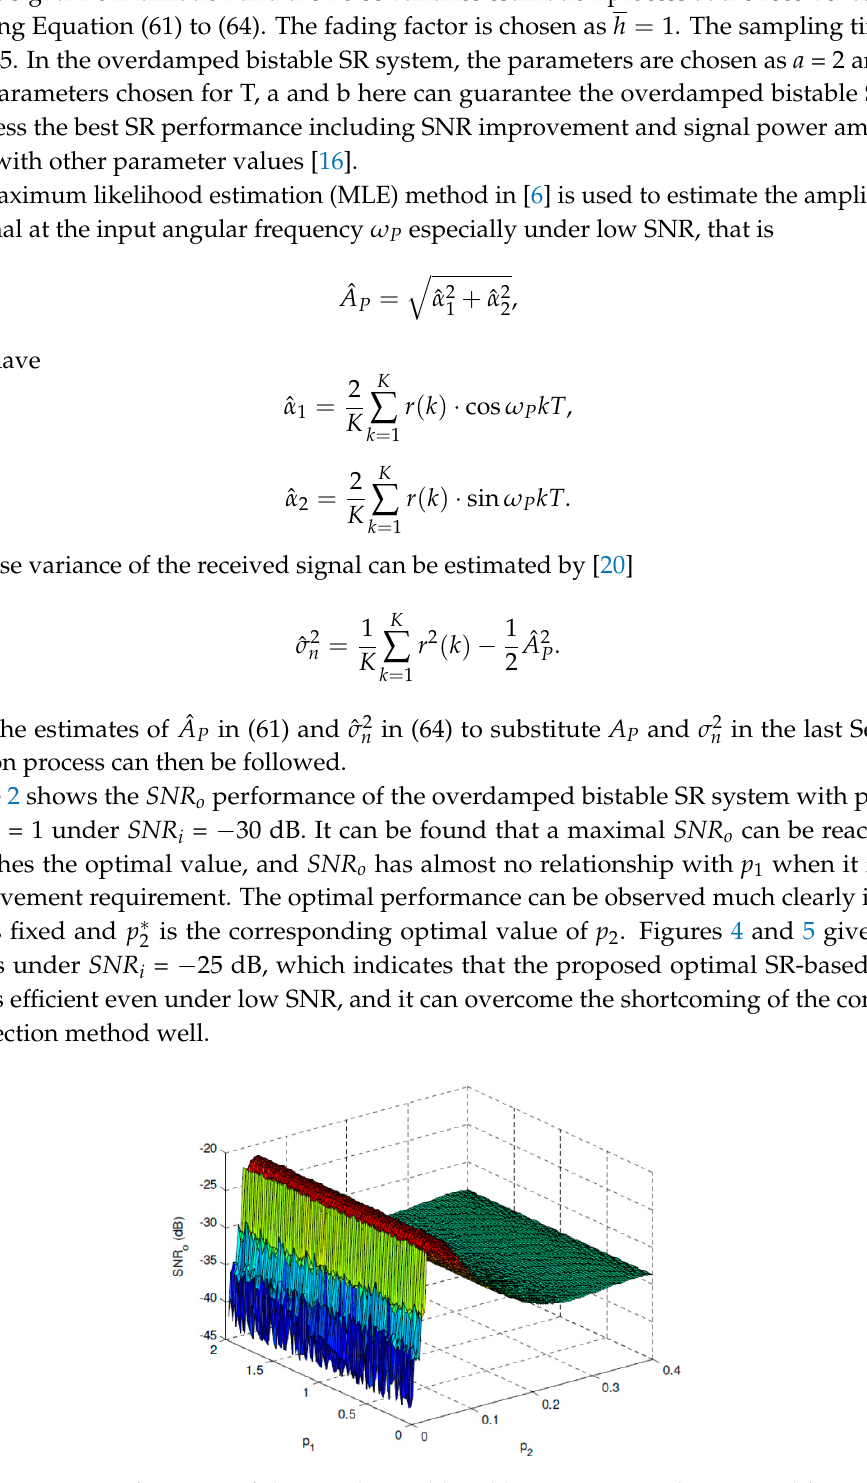
Figure 2. SNR o performance of the overdamped bistable SR system with a = 2 and b = 1 under SNR i = − 30 dB.